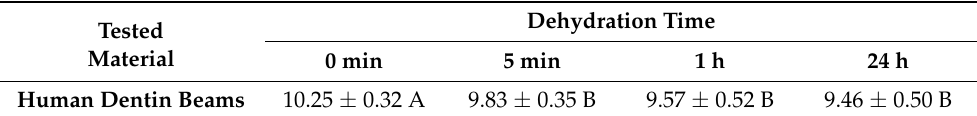
Table 2. Mean weight ± standard deviation of human dentin beams in mg (n = 10 beams)